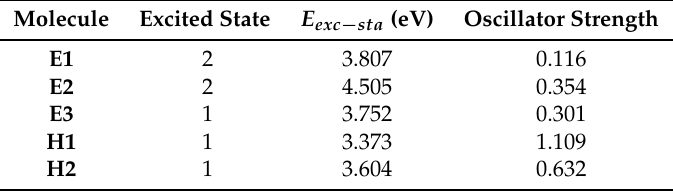
Table 3. Calculated energies (in eV) of the lowest excited states with a large oscillator strengths ( > 0.1), in the amorphous materials based on the five organic molecules investigated in this work. Calculations were carried out within the time-dependent DFT framework using the combination PBE0/Def2TZVPP and a state-specific solvation calculation, with the dielectric constant ε derived as explained in the main text and reported in Table 1.